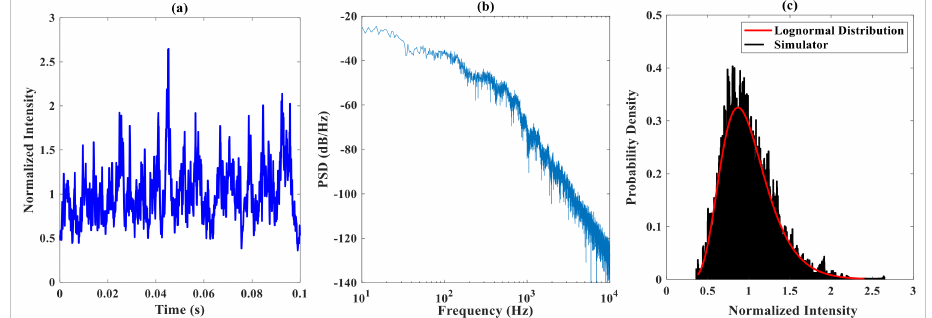
Figure 3. MZM-based fading-simulator-emulated scintillation effect with a σ 2 domain, and ( c )